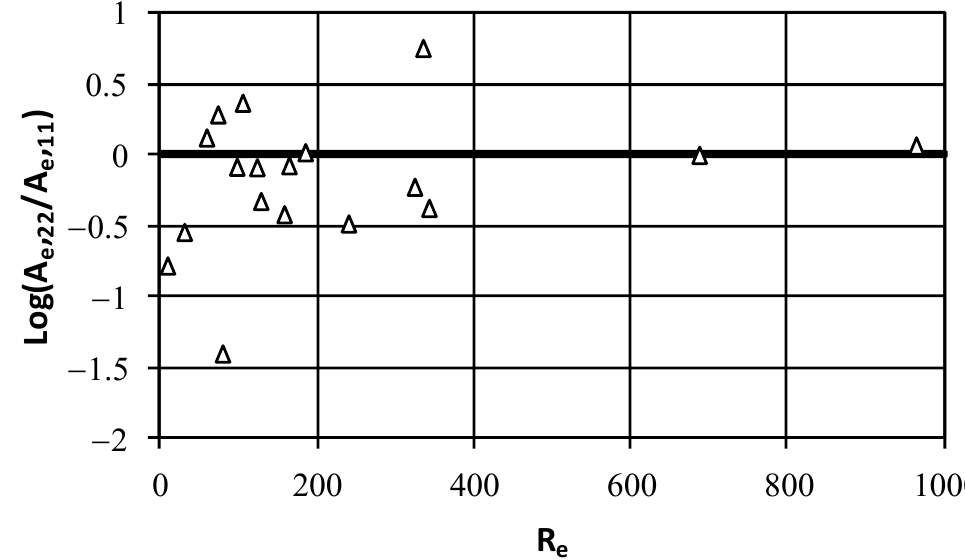
Figure 5. Log of the ratio between soil losses, A e , measured in the plots with length λ = 22 m and plots with λ = 11 m vs. the erosivity index, R e (MJ mm ha −1 h −1 ) (modified from [29]). Bagarello et al. [30] established plot length and steepness effects on A e , C e , and the event runoff coefficient Q Re , i.e., V e per unit rainfall depth, using measurements collected until February 2012. The database was developed by considering, for a given event, the individual plots yielding a simultaneous measurement of both A e and V e . A total of 317 data were collected for the plots with λ = 11, 22, 33, and 44 m and s = 14.9% were consid- ered for testing plot length effects. The selected events were those with the simultaneous functioning of at least a plot for each length to obtain reasonably homogeneous and com- parable data. The 278 data collected for the 22 m long plots with s = 14.9, 22, and 26% were considered for testing plot steepness effects. The selected events were characterized by the simultaneous functioning of at least a plot for each steepness value. The mean and median values of the erosive and hydrological variables, which were expressive of the long-term average responses, confirmed that, generally, A e did not vary appreciably with λ because the decrease in runoff coefficient was offset by an increase in sediment concentration (Fig- ure 6). Therefore, how the physical erosion process occurred at the sampled site was not consistent with the assumption made in the USLE/RUSLE that soil loss per unit area in- creases with plot length. The authors verified that the short duration of individual rain showers, which determines a flow discontinuity along the hillslope [31], can favor the oc- currence of more noticeable sediment deposition on longer plots, determining practically constant A e values on plots differing in length. The moderately increasing relationship of C e against λ was attributed to the advanced sediment transport efficiency on the longest plots, where concentrated flow, which notoriously has a higher capacity to transport sed- iment as compared to the overland flow, is expected to be more pronounced.